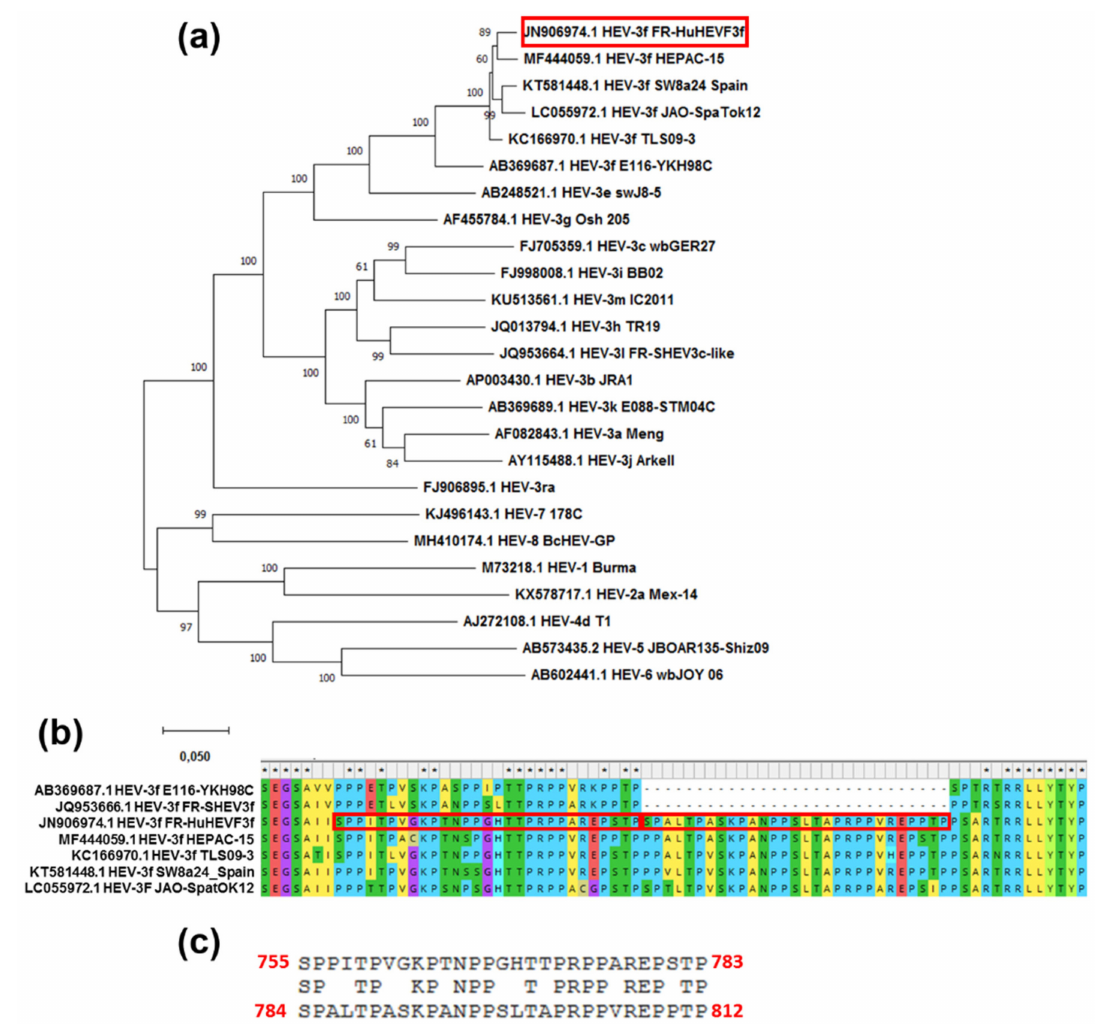
Figure 5. Duplication of a 29 amino acid sequence within the HVR of FR-HuHEVF3f ORF1. ( a ) Phylogenetic tree of 25 HEV complete or nearly complete sequences. This analysis includes FR-HuHEVF3f, different referenced genotypes of HEV (HEV-1 to -8) and subtypes of HEV-3 as well the 4 HEV-3f strains shown to be the most closely related to FR-HuHEVF3f in a blast analysis (HEPAC-15, TLS09-3, SW8a24 Spain and JAO-SpaTok12). The tree was constructed by using the Maximum Likelihood method and Tamura-Nei model based on the Clustal W alignment in MEGA X software. Bootstrap values were obtained from 1000 replicates. The GenBank database accession number of these complete sequences is indicated. FR- HuHEVF3f is indicated by a red box. Scale bar represents nucleotide substitutions per site. ( b ) Alignment of FR-HuHEVF3f with other HEV-3f strains revealed the presence of a duplicated 29 amino acid region in the hypervariable region (HVR) domain of ORF1 as indicated by red boxes. ( c ) Alignment of the duplicated sequence. The amino acid position within FR-HuHEVF3f ORF1 is indicated in